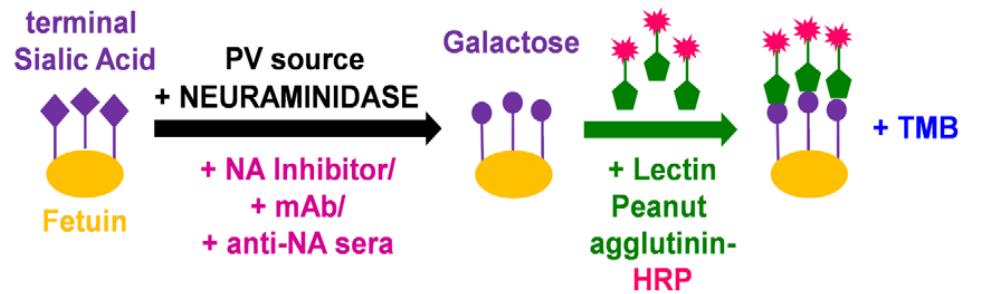
Figure 1. Illustration of main reactions in the pseudotype virus enzyme-linked lectin assay (pELLA). The substrate fetuin is coated on each well of a 96-well plate. Neuraminidase, added via the NA PV we generated, then cleaves the terminal sialic acid (SA) residues of the substrate fetuin, giving anti-NA antisera, the action of neuraminidase is inhibited, and this can then be measured indirectly via pELLA. The terminal galactose residues that are present due to the action of